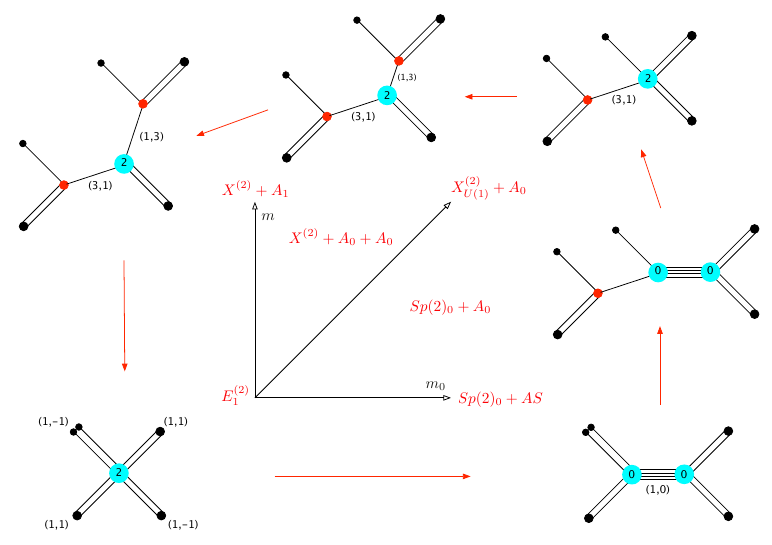
Figure 3 . The phases of E (2) . The number inside a non-trivial junction denotes its number of 1 local deformarions, i.e. Coulomb